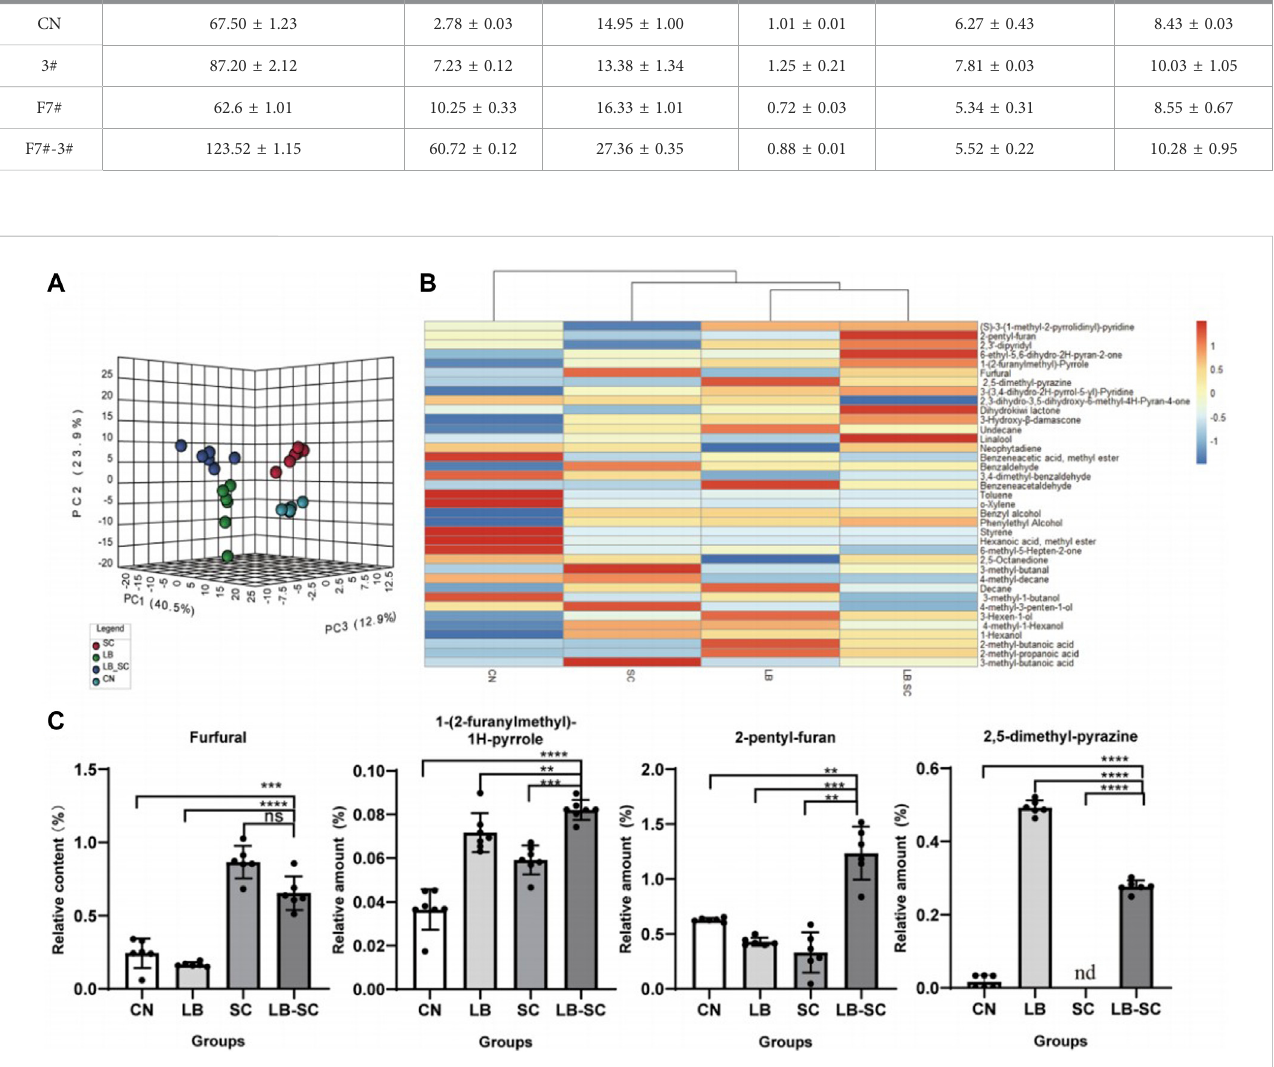
FIGURE 7 Optimizationof volatilecomponentanalysis bycombinationofstrainsfour# and3# (A) PCA analysis ofcompound componentsfrom combinedculture of strains 44# and 3#. (B) . Heat map analysis of compound and differential components of individual strains (C) . For the analysis of the content of some odorant components, LB was used for pure culture of strain 44#, SC for pure culture of strain 3#, and LB-SC for 44#-3# combined